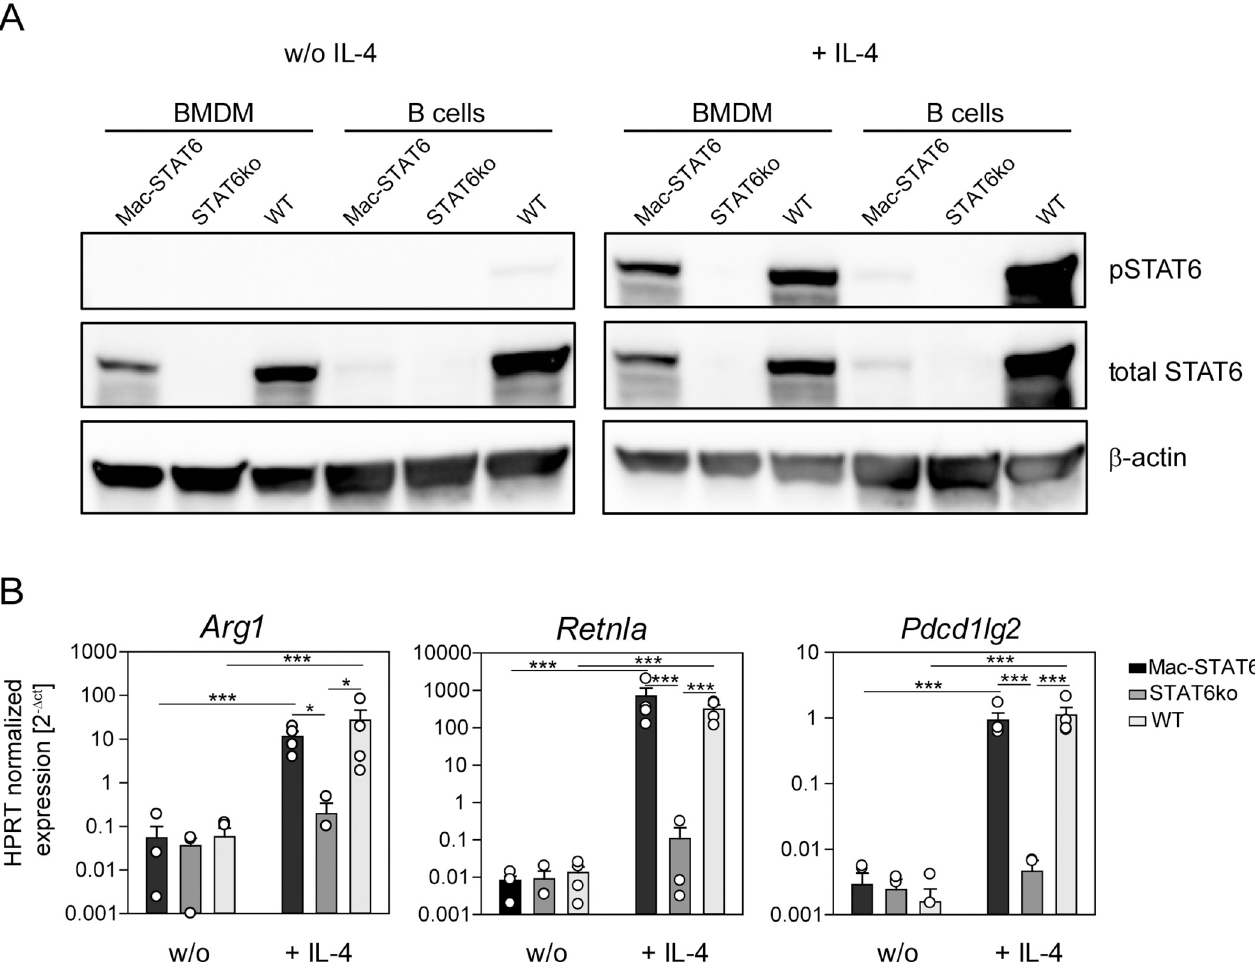
Fig 1. Functional expression of STAT6 in macrophages of the Mac-STAT6 mouse. Bone marrow derived macrophages (BMDM, purity > 95%) were generated and splenic B cells (purity > 90%) isolated from mice that do express STAT6 only under control of the LysMCre promoter (Mac-STAT6), STAT6 knockout mice (STAT6ko) and BALB/c wild-type (WT) controls. A) Western blot of unstimulated (w/o) and IL-4-stimulated BMDM and B cell lysates of the indicated genotypes for phosphorylated STAT6 (pSTAT6), total STAT6 and β -actin as loading control. Western blot is representative for three to five mice per genotype from two independent experiments. B) qRT-PCR of BMDM from either Mac-STAT6, STAT6ko or WT mice stimulated with 20 ng/ml IL-4 for 48 hrs. Bars show mean expression + SEM of Arg1 , Retnla and Pdcd1lg2 normalized on Hprt of three to four mice per genotype out of two experiments. Statistical significance was determined by Two-Way-ANOVA with Holm-Sidak post-hoc testingon log-transformed data. *** p < 0.001; * p < 0.05. https://doi.org/10.1371/journal.ppat.1011296.g001 of granuloma regions, Relm- α was abundantly expressed in IL-4c-treated Mac-STAT6 mice, more prominent than in the PBS or STAT6ko controls and co-staining with CD68 and DAPI confirmed Relm- α expression in AAMs with similar frequency in Mac-STAT6 and WT mice (Fig 2C). In contrast, compared to WT mice fewer macrophages expressed Arg1 in Mac- STAT6 and STAT6ko mice in all different conditions (Fig 2D). Flow cytometry analysis of cells from the peritoneal cavity (PEC) was used to determine the efficiency of AAM polariza- tion of PEC macrophages, defined by increased PD-L2 surface expression (S1A and S1B Fig). PD-L2 was upregulated significantly in IL-4c-treated Mac-STAT6 mice compared to STAT6ko mice and upregulation was comparable to the level in WT mice (S1C Fig). In addition, RT-PCR of sorted PEC macrophages from IL-4c-treated Mac-STAT6 mice revealed their expression of other AAM-associated markers (S1D Fig). We further analysed mice on day 2